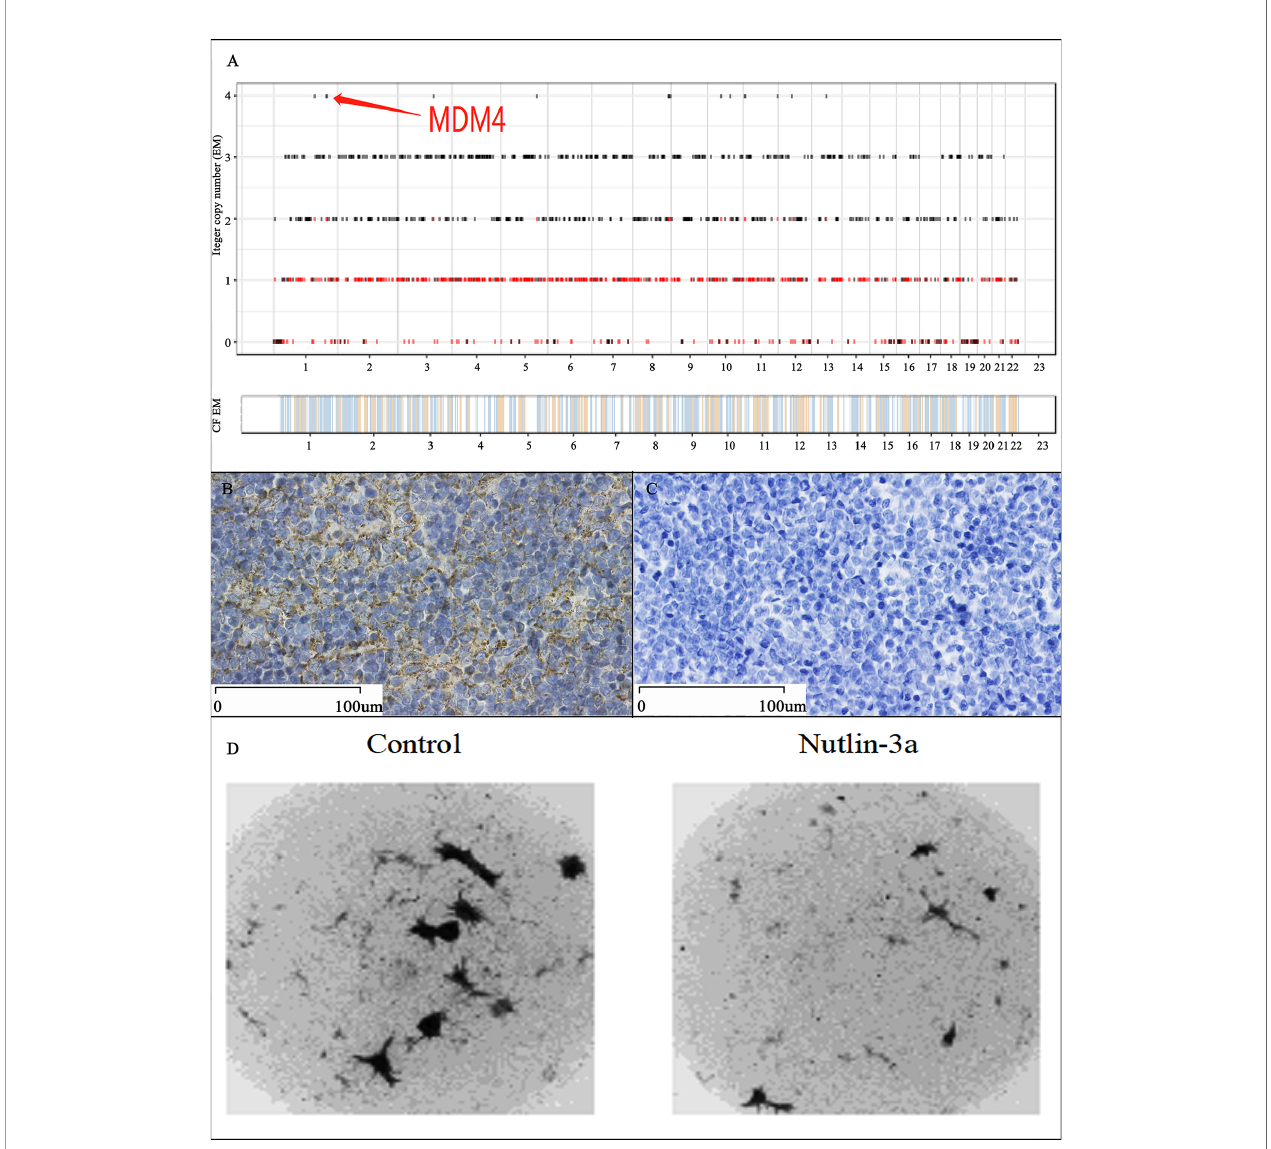
FIGURE 3 | Genetic Testing and Validation Results. The WES result indicated that the MDM4 ampli fi ed in this thymoma cells, which is the unique driver gene in 99 mutated genes among 20,000 exons (A) ; Immunohistochemical staining showed positivity for MDM4 (B) and negativity for p53 (C) ; The drug sensitivity test showed that the growth rate of thymoma cells was 41.22% in Nutlin-3a group, compared with 78.66% in the control group, which meant that the thymoma cells were highly sensitive to Nutlin-3a (D)